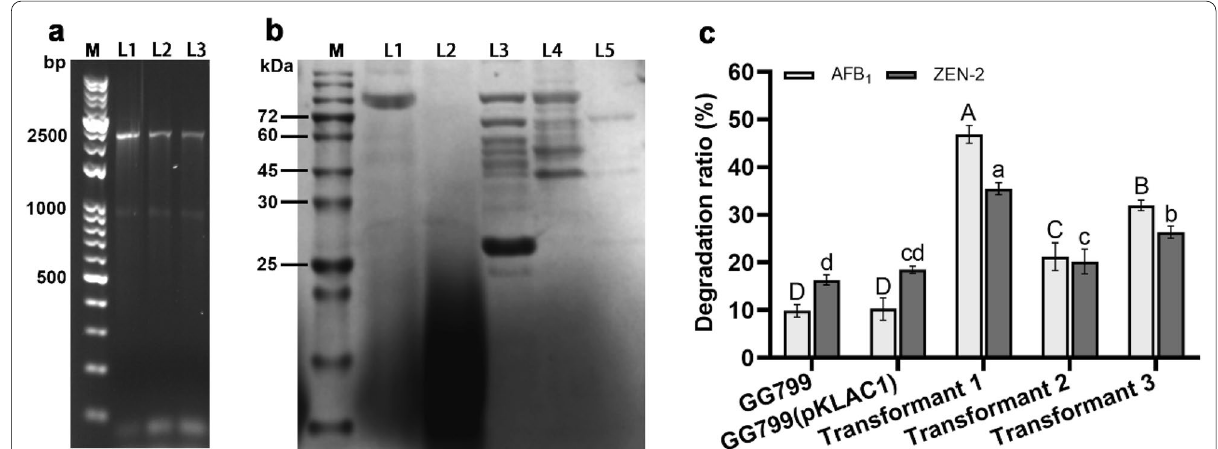
Fig. 2 Construction and expression of fusion enzyme ZPF1, and the degradation efficiency of AFB 1 and ZEN by ZFP1. a The electrophoresis of the PCR results of the 3 positive transformants: M: DNA marker; L1 to L3: PCR results of 3 positive GG799(pKLAC1-ZPF1) transformants. b SDS-PAGE results of culture supernatants of the 3 positive transformants: M: Protein marker; L1: K. lactis GG799 supernatant proteins; L2: K. lactis GG799(pKLAC1) supernatant proteins; L3 to L5: Three K. lactis GG799(pKLAC1-ZPF1) transformants’ supernatant protein. c Degradation results of AFB 1 (reaction system 1) and ZEN (reaction system 2) by the 3 transformants. Different letters above the histogram are significant differences ( p <